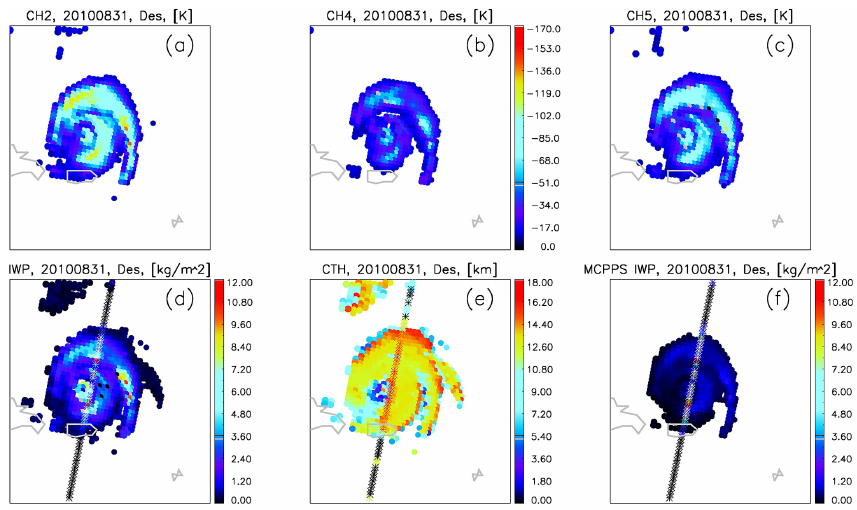
Figure 7. T cir at CH#2 (a) , CH#4 (b) and CH#5 (c) and retrieved NOAA-18 MHS IWP (d) , h t (e) and MSPPS IWP (f) for Hurricane Earl at 01:54LST on 31 August 2010 (Cuba is the island to the left of the plot). The IWP ( h t ) calculated from the collocated and coincident CloudSat overpasses (averaged onto MHS footprints) are marked by color crosses that share the same color bars with MHS. Note that the blank in the IWP map means that the IWP retrieval is not performed or has failed because it is below the sensitivity level of this algorithm, while CloudSat overpasses show a zero IWP value in most places away from the